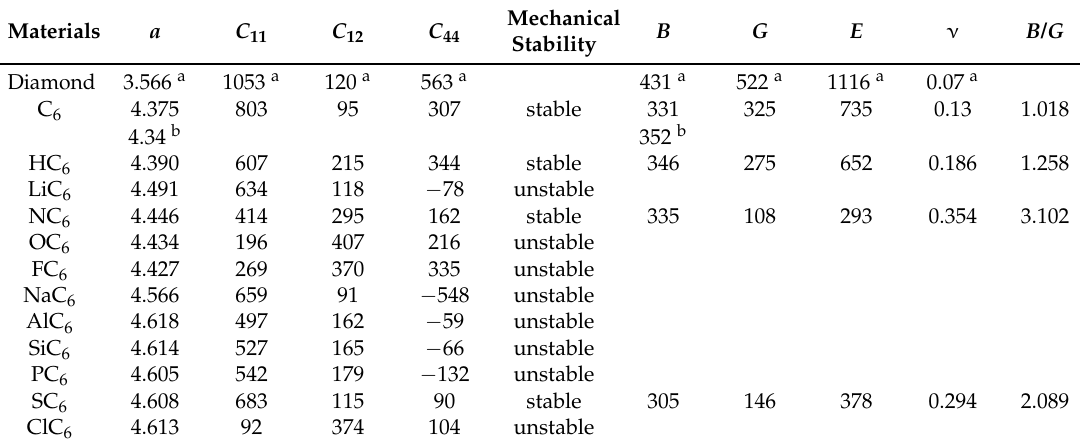
Figure 1. Unit cell of XC 6 ( a ) and XC 12 ( b ). The black and blue spheres represent C and X atoms, respectively. Table 1. Calculated lattice parameter a , elastic constants C ij (GPa), mechanical stability, bulk modulus